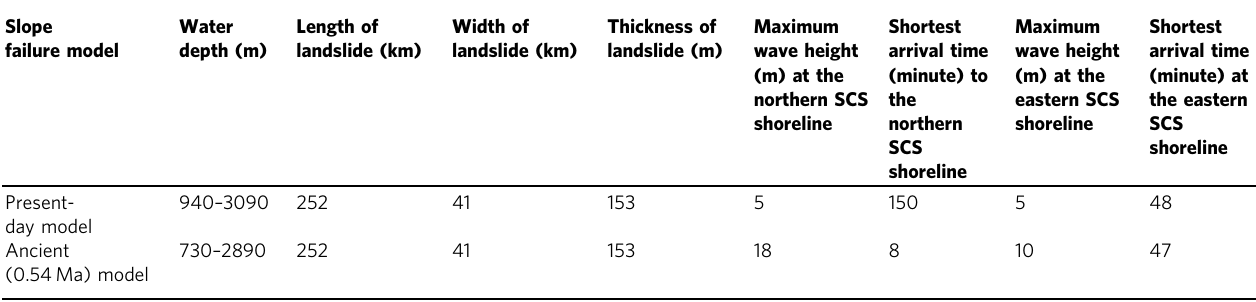
Table 1 Modeled parameters and main results pertaining to the present-day and 0.54 Ma models.